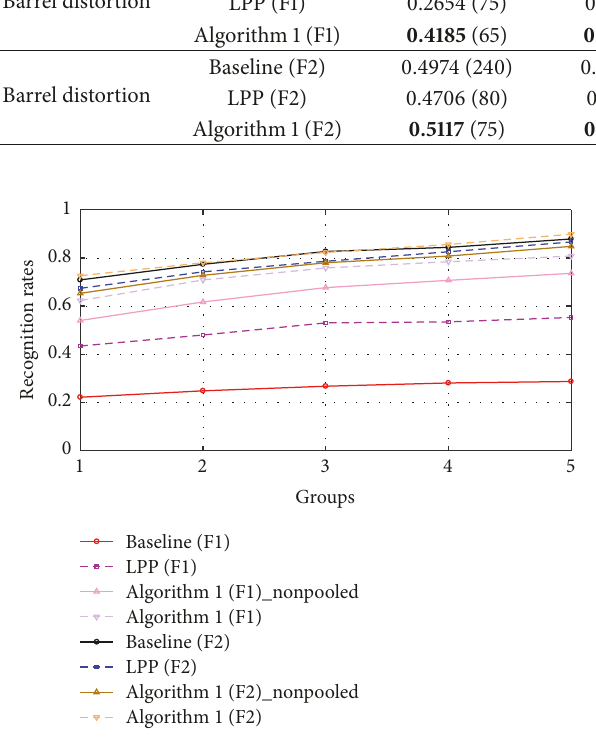
Figure 9: The recognition rates on subAR face database over “F1” and “F2”